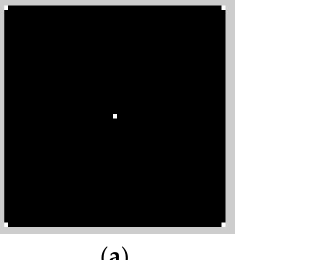
( b ) Figure 2. Dual relationship between xy -space and ρθ -space. ( a ) xy -space; ( b ) ρθ -space. The xy -space is the image space while the ρθ -space is sometimes called Hough space. The properties of point-to-line dual relationship between image space and Hough space can be summarized as follows. •